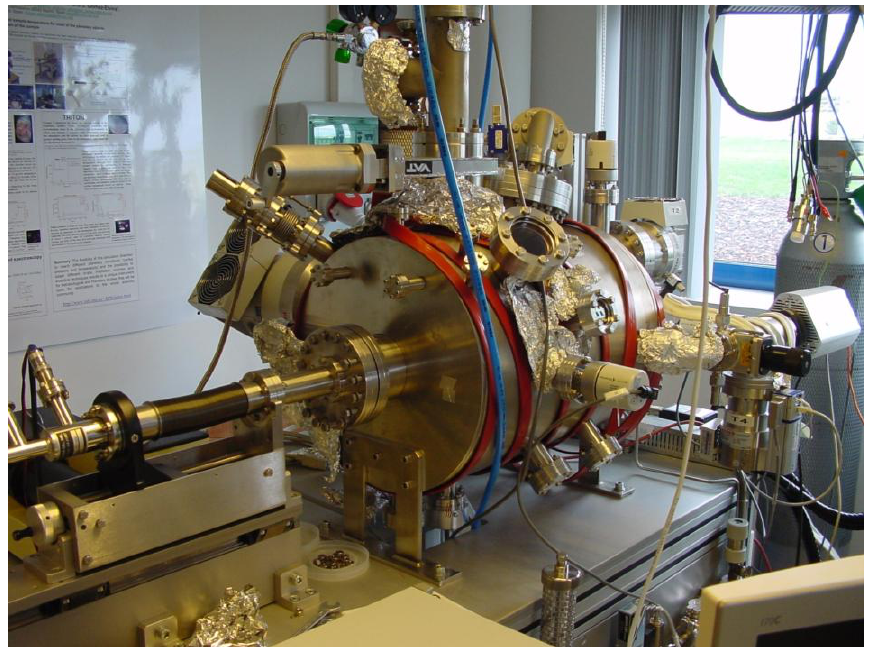
Figure 3. Photograph of the Planetary Atmosphere and Surfaces Chamber (PASC), planetary-simulation